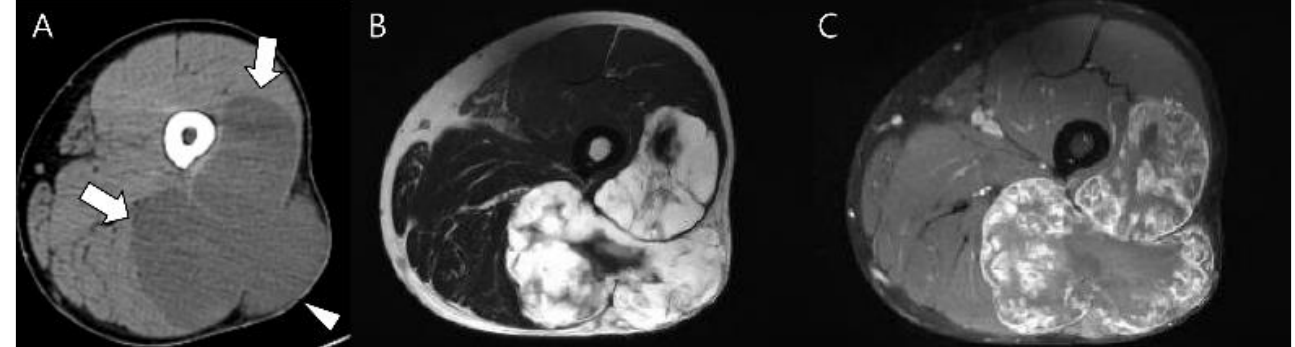
Figure 14. Extraskeletal myxoid chondrosarcoma of the right thigh in a 46-year-old man. ( A ) Axial CT scan reveals a lobulated, low-density soft tissue mass (arrows) without chondral-type mineralization between the vastus lateralis and biceps femoris muscles extending to the subcutaneous fat layer (arrowhead). ( B , C ) Axial T2-weighted and T1-weighted enhanced images show a soft tissue mass with high signal intensity and peripheral rim and septal enhancement.